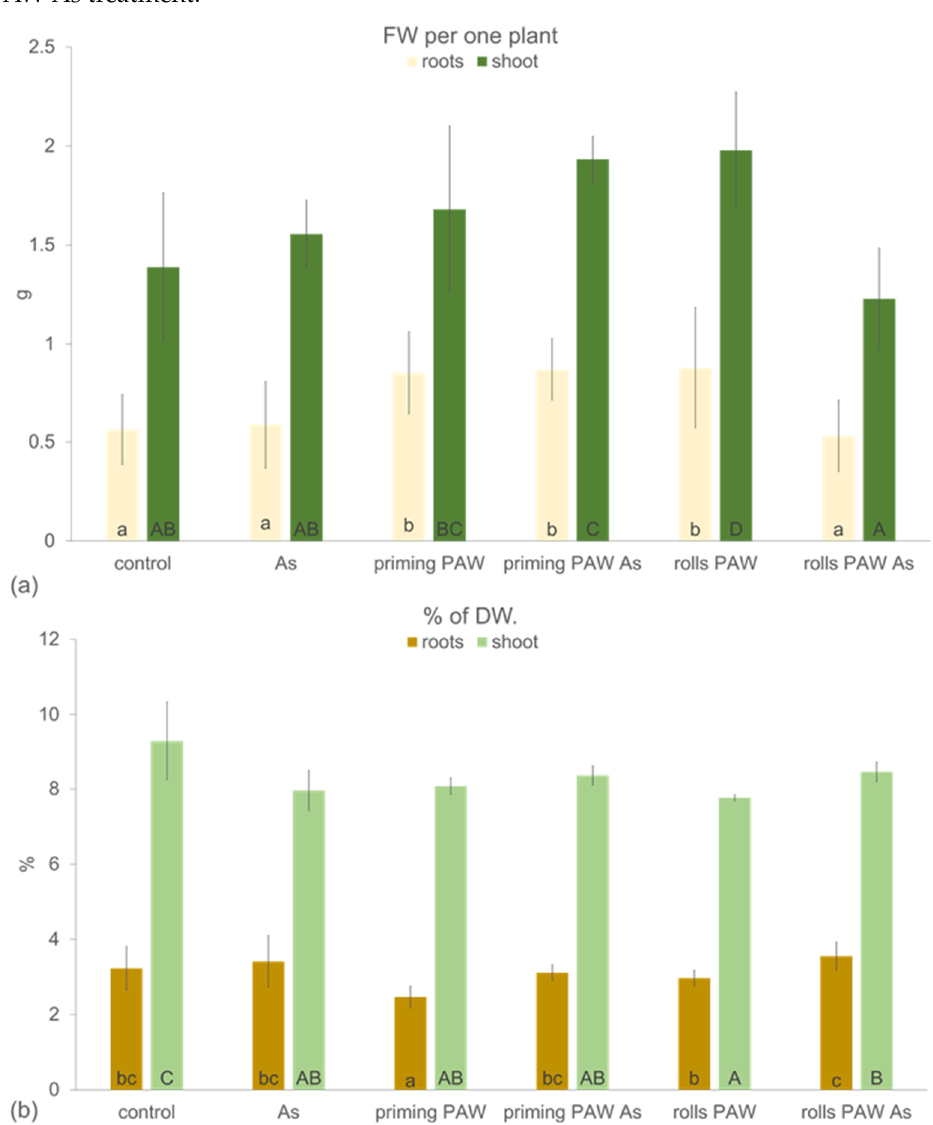
Figure 5. Growth parameters of the maize plants (hybrid Bielik) after 10 days of hydroponic cultivation as control or pre-treated with PAW (priming PAW and rolls PAW treatments) without and with As; the fresh weight per one plant ( a ) and the % of the dry weight ( b ). Values are means of four replicates ± SD. Different letters denote a significant difference between the treatments.